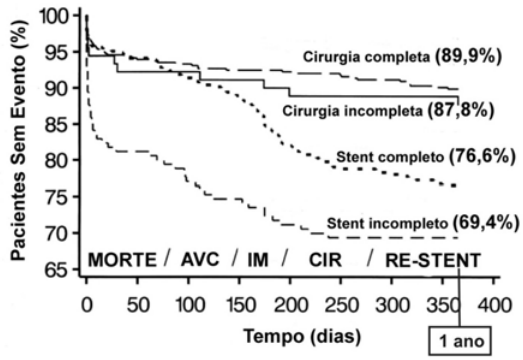
Fig. 6 - Curva de Kaplan-Meier mostrando sobrevivência livre de Eventos Cerebrovasculares após 1 ano, baseada